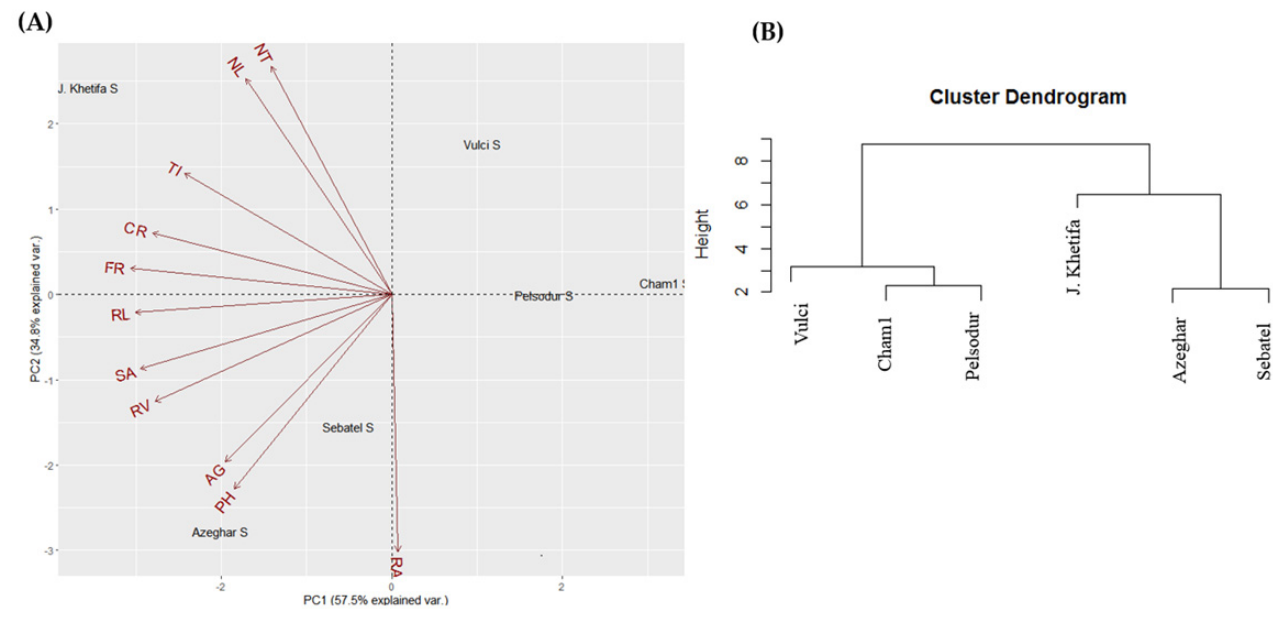
Figure 3. Biplot of the principal component analysis ( A ) and hierarchical analysis ( B ) of the shoot and root traits under salt conditions. For abbreviations, please see the abbreviation list at the end of the